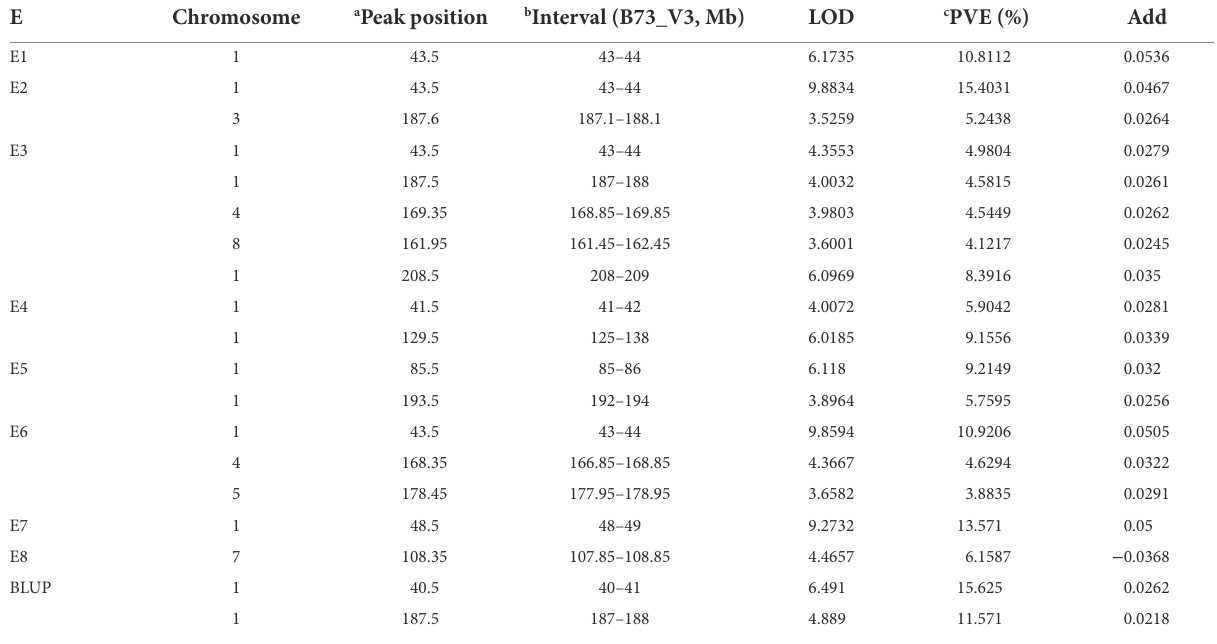
TABLE 3 Quantitative trait loci (QTL) mapping for Fusarium ear rot resistance using a recombinant inbred line population derived from Qi319 and Ye478.